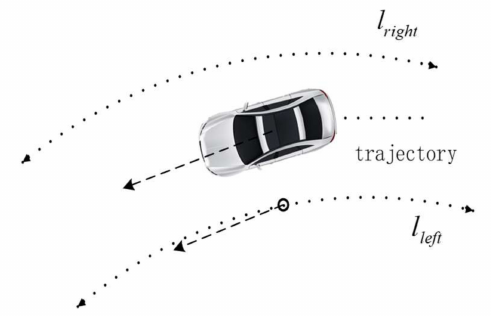
Figure 3. Schematic diagram of lane virtual candidate points and feature